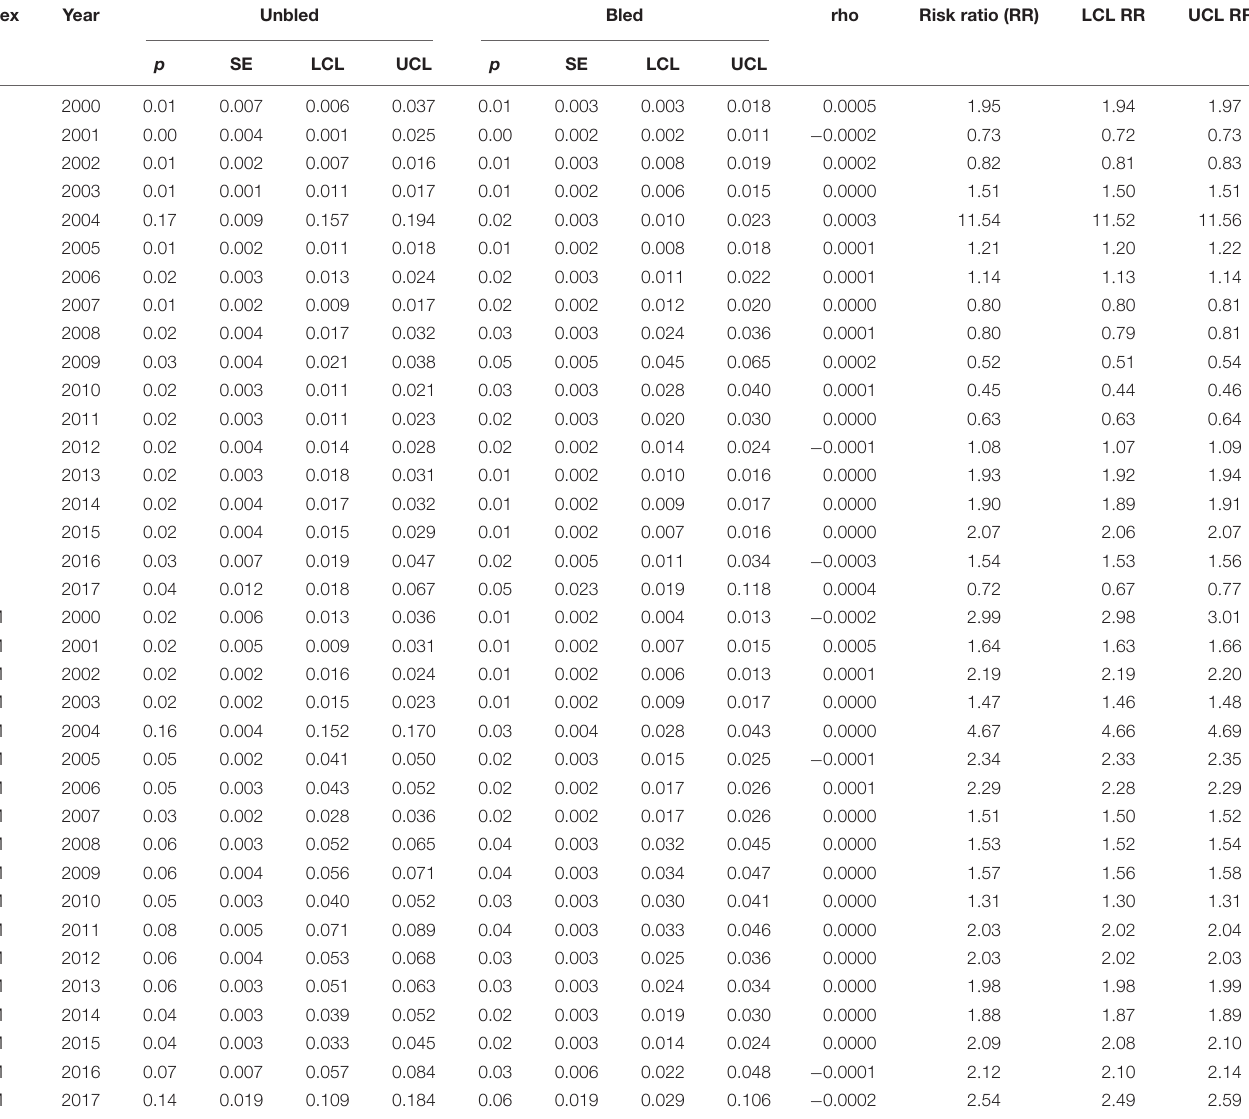
TABLE 7 | Capture probability ( p ) for the top model for tagged horseshoe crabs released in the Delaware Bay population (Delaware Bay and coastal Delaware to Virginia regions) from 1999 to 2017. Sex Year Unbled Bled